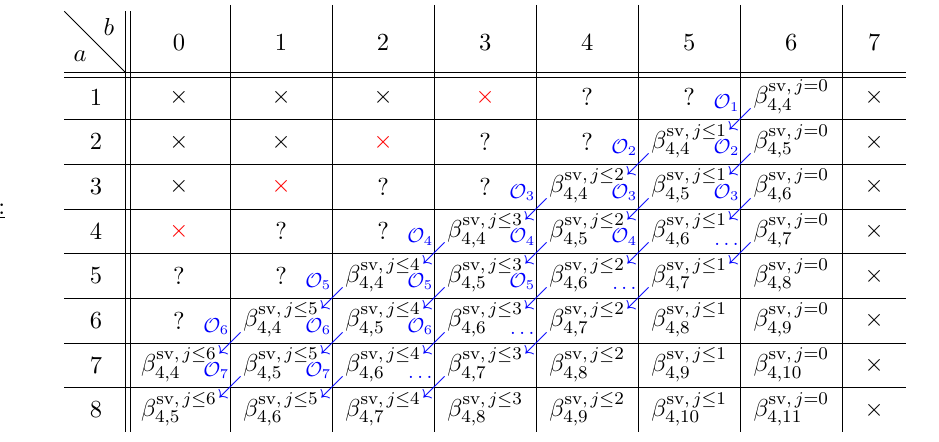
(8 , 0 b ) , together with 0